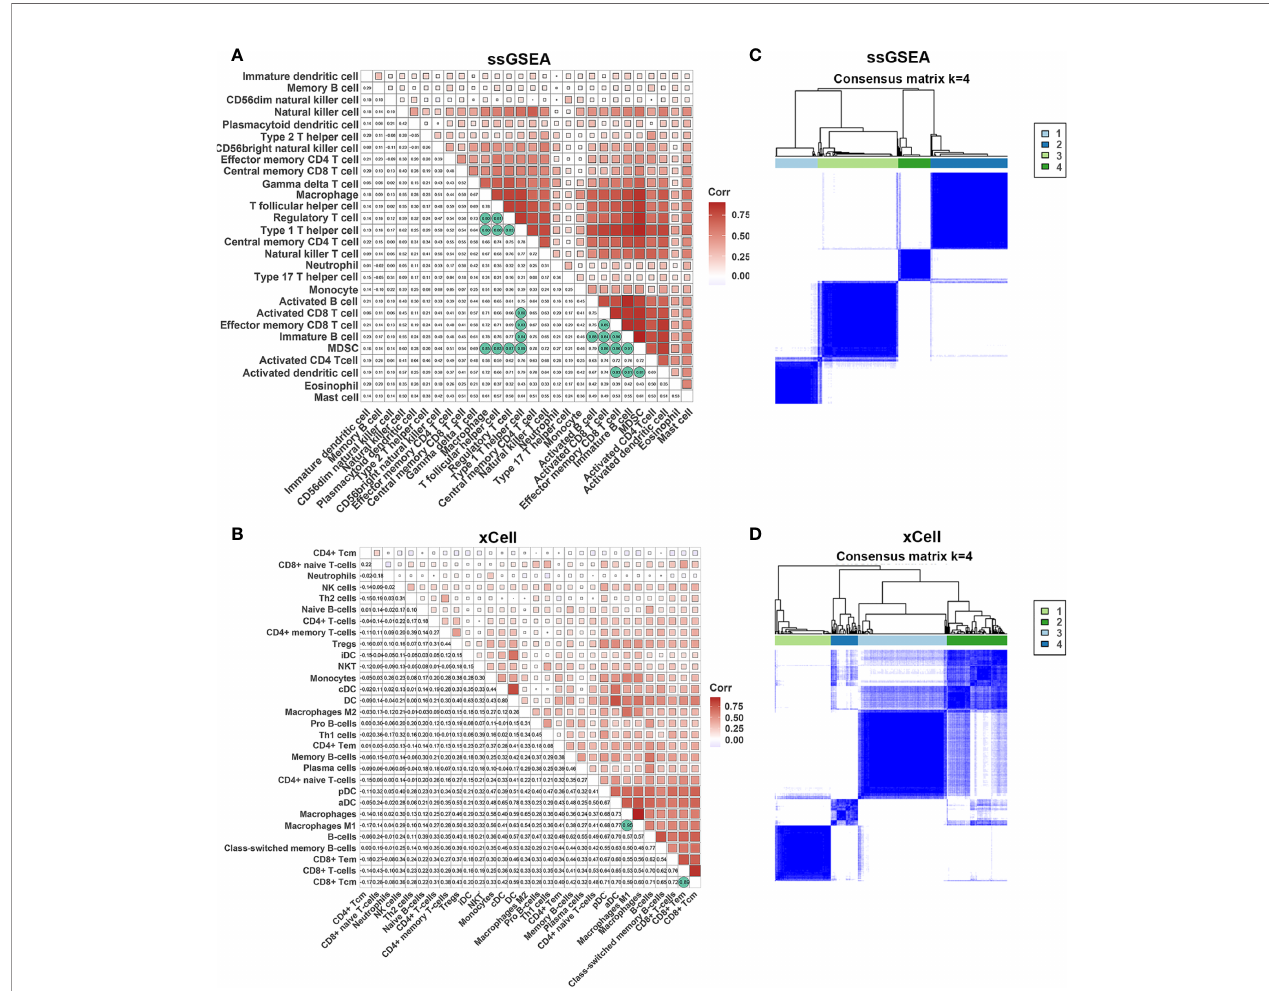
FIGURE 3 | Correlations of immune cells. (A, B) Correlation of immune cells in tumor tissues estimated by ssGSEA and xCell. (C, D) The heatmap shows the consensus clustering of CC based on levels of immune cells estimated by ssGSEA and